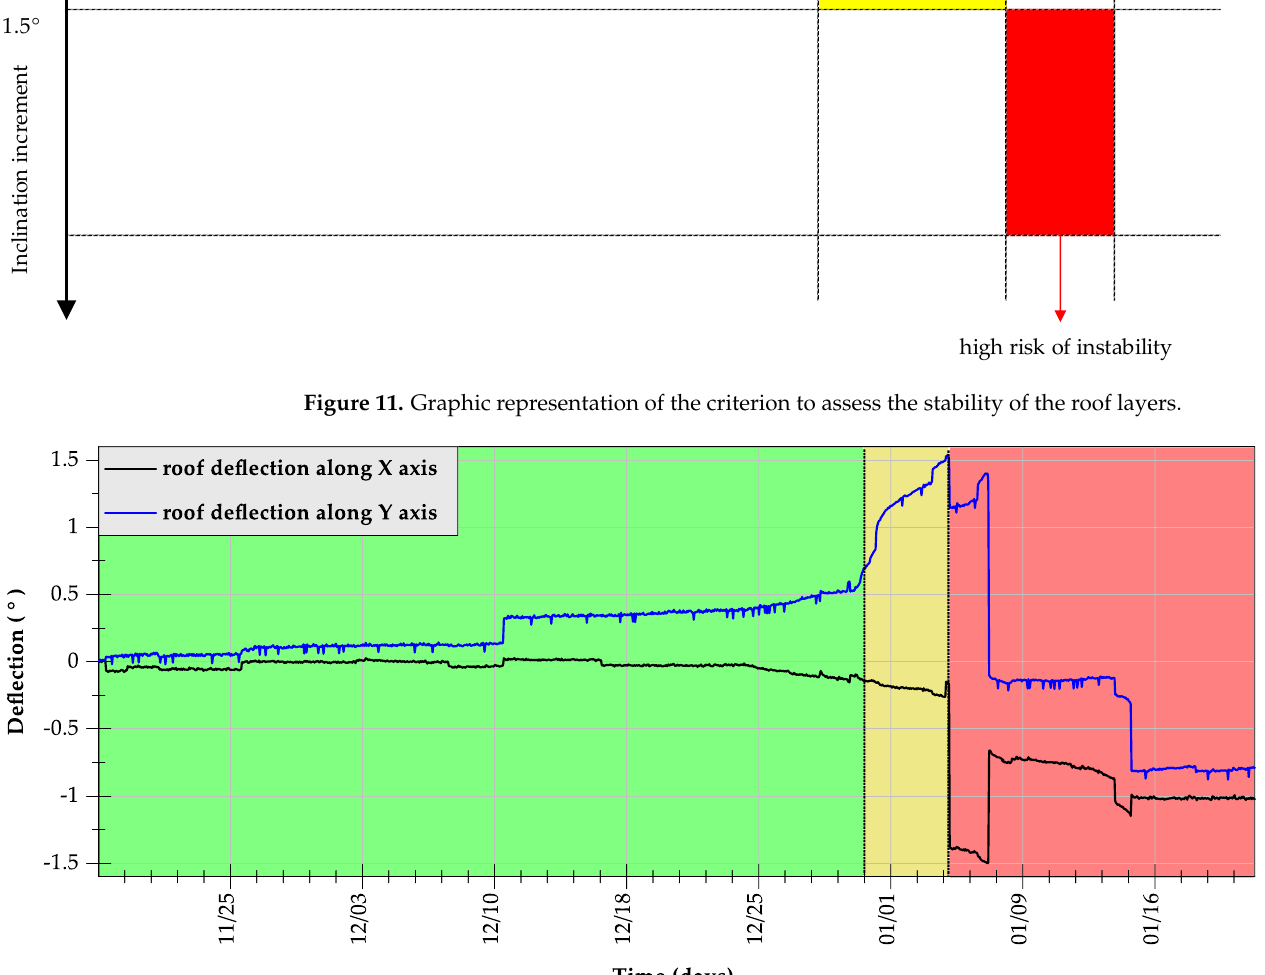
Figure 12. An exemplary case of ground failure prediction with the use of an inclinometric sensor.